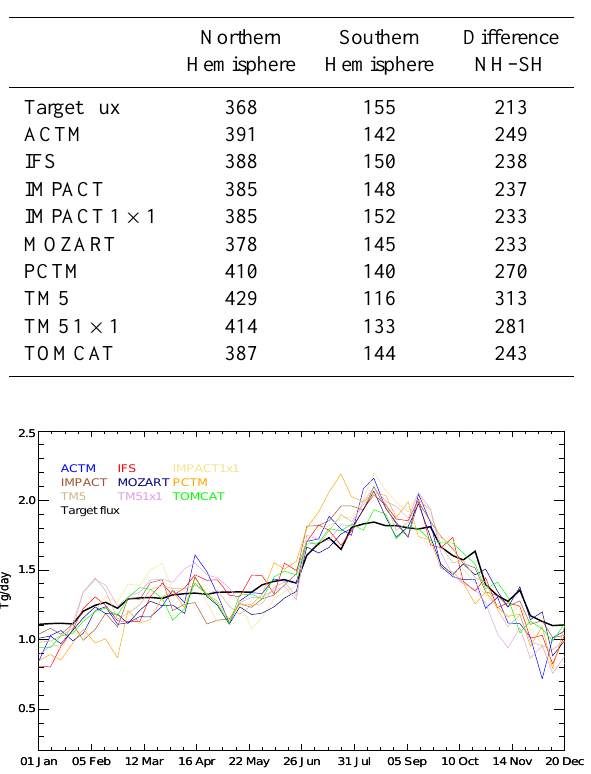
Table 3. Estimates of hemispheric methane fluxes in teragrams of methane per year (Tgyr − 1 ) for every TransCom model inver- sion. Inverted fluxes in the Northern (NH) and in the Southern Hemisphere (SH) are presented in the first two columns. The inter- hemispheric gradient (NH estimate–SH estimate) is shown in the third column.